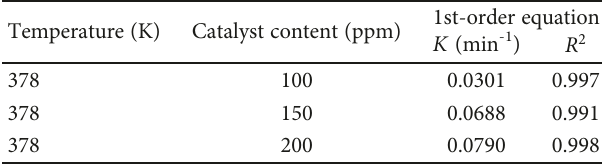
Figure 8: Isocyanate conversion versus curing time of PSU with di ff erent TEA content at 105 ° C (a) and the corresponding fi rst-order rate law. Table 3: First-order kinetic parameters of PSU curing process at 105 ° C with di ff erent TEA content.